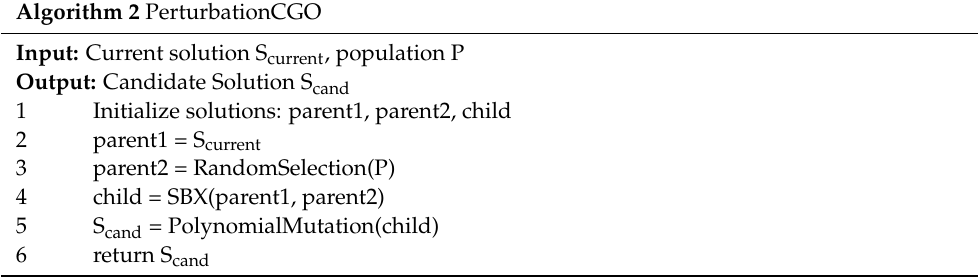
Algorithm 2 PerturbationCGO